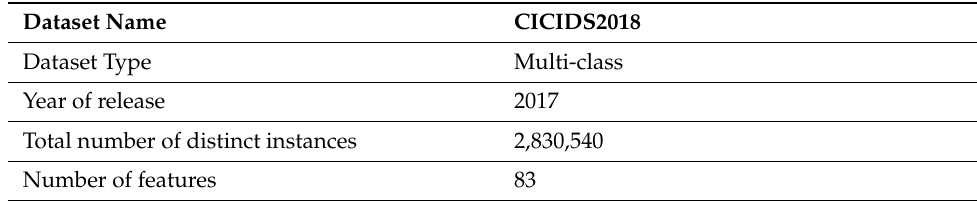
Table 3. CICIDS2017 Dataset